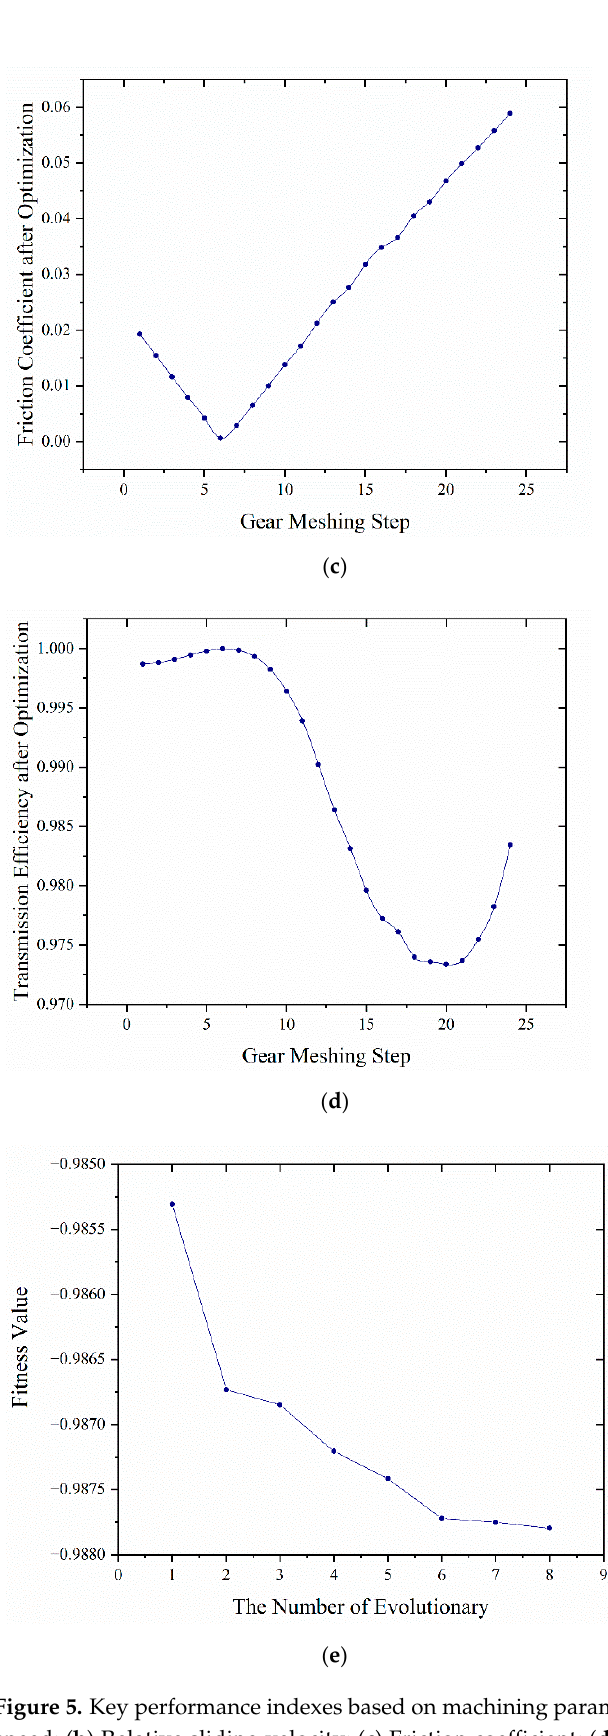
Figure 5. Key performance indexes based on machining parameter optimization. ( a ) Entertainment speed; ( b ) Relative sliding velocity; ( c ) Friction coefficient; ( d ) Transmission efficiency; ( e ) Fitness values of PSOGSA.